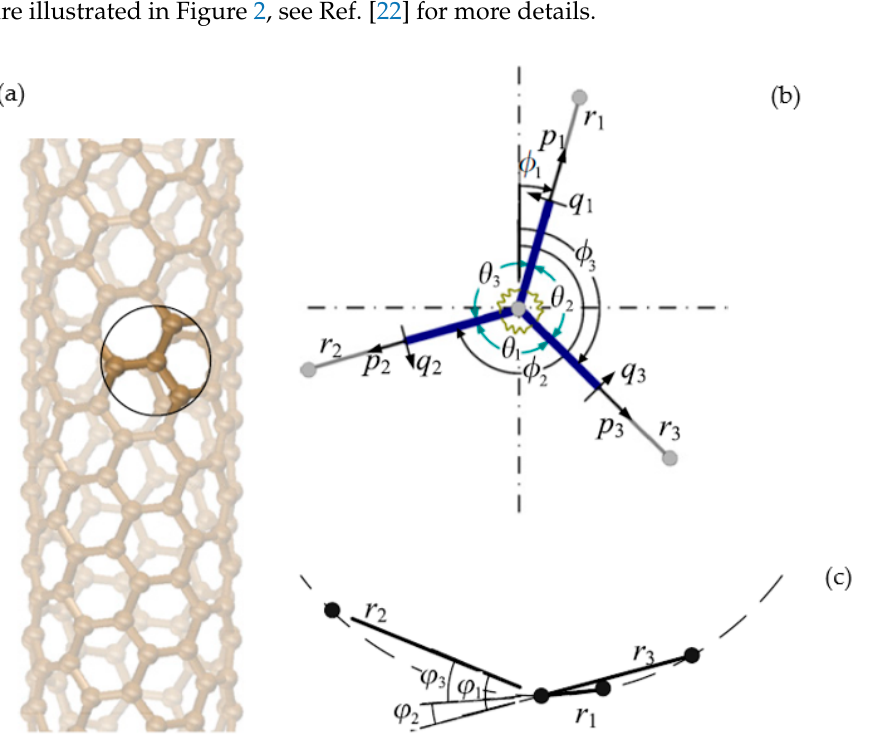
Figure 2. Schematic illustration of a ( r , s ) single-walled carbon nanotube. ( a ) Global structure with a zoom of a single representative atom; ( b ) side view of the local structure; ( c ) top view of the local structure. Reprinted with permission from Ref. [22], 2006, The Royal Society.